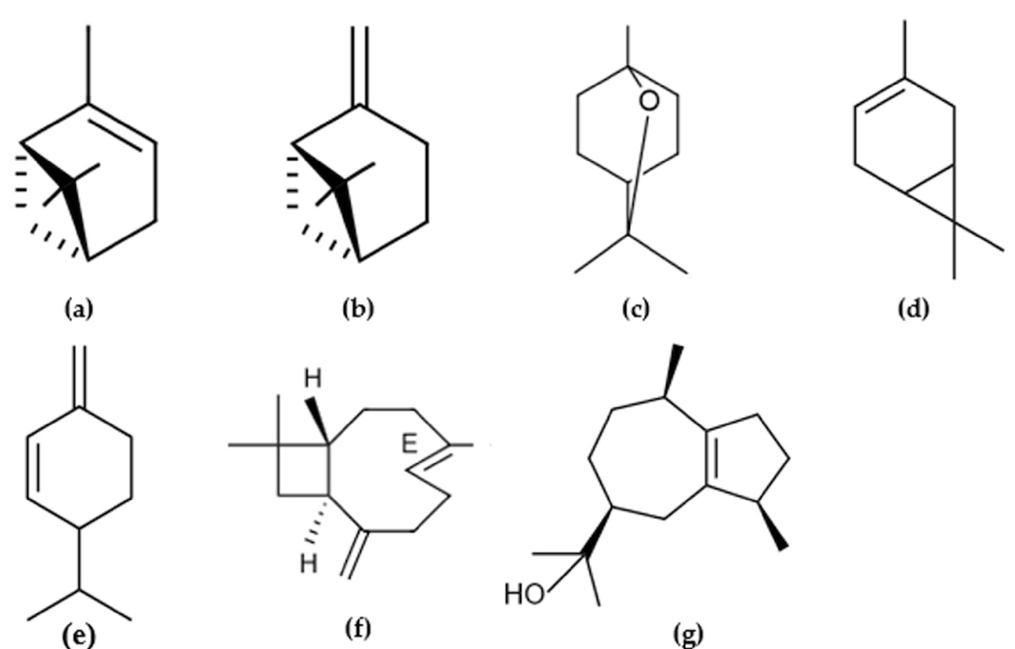
Figure 1. Structures of selected constituents (contents > 4%) identified in essential oils (leaves and flowers) of Lepechinia paniculata : ( a ) α -Pinene; ( b ) β -Pinene; ( c ) 1,8-Cineole; ( d ) δ -3-Carene; ( e ) β -Phellandrene; ( f ) ( E )-Caryophyllene; ( g ) Guaiol. A typical chromatogram of Lepechinia paniculata essential oil is shown in Figure